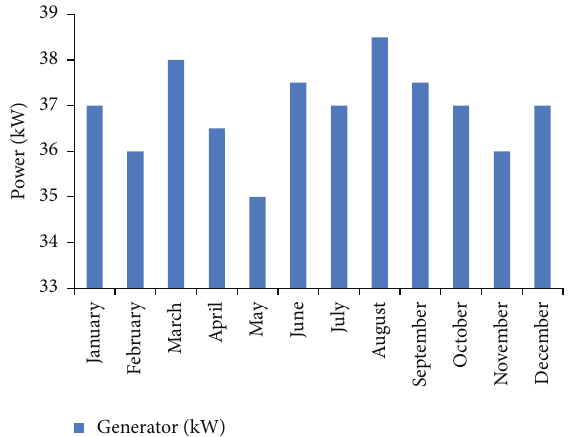
Figure 8: Monthly average of electrical power production of diesel- only generator set [7]. Table8:Comparisonsimulationofexistingsystem(dieselonly)and proposed hybrid system.